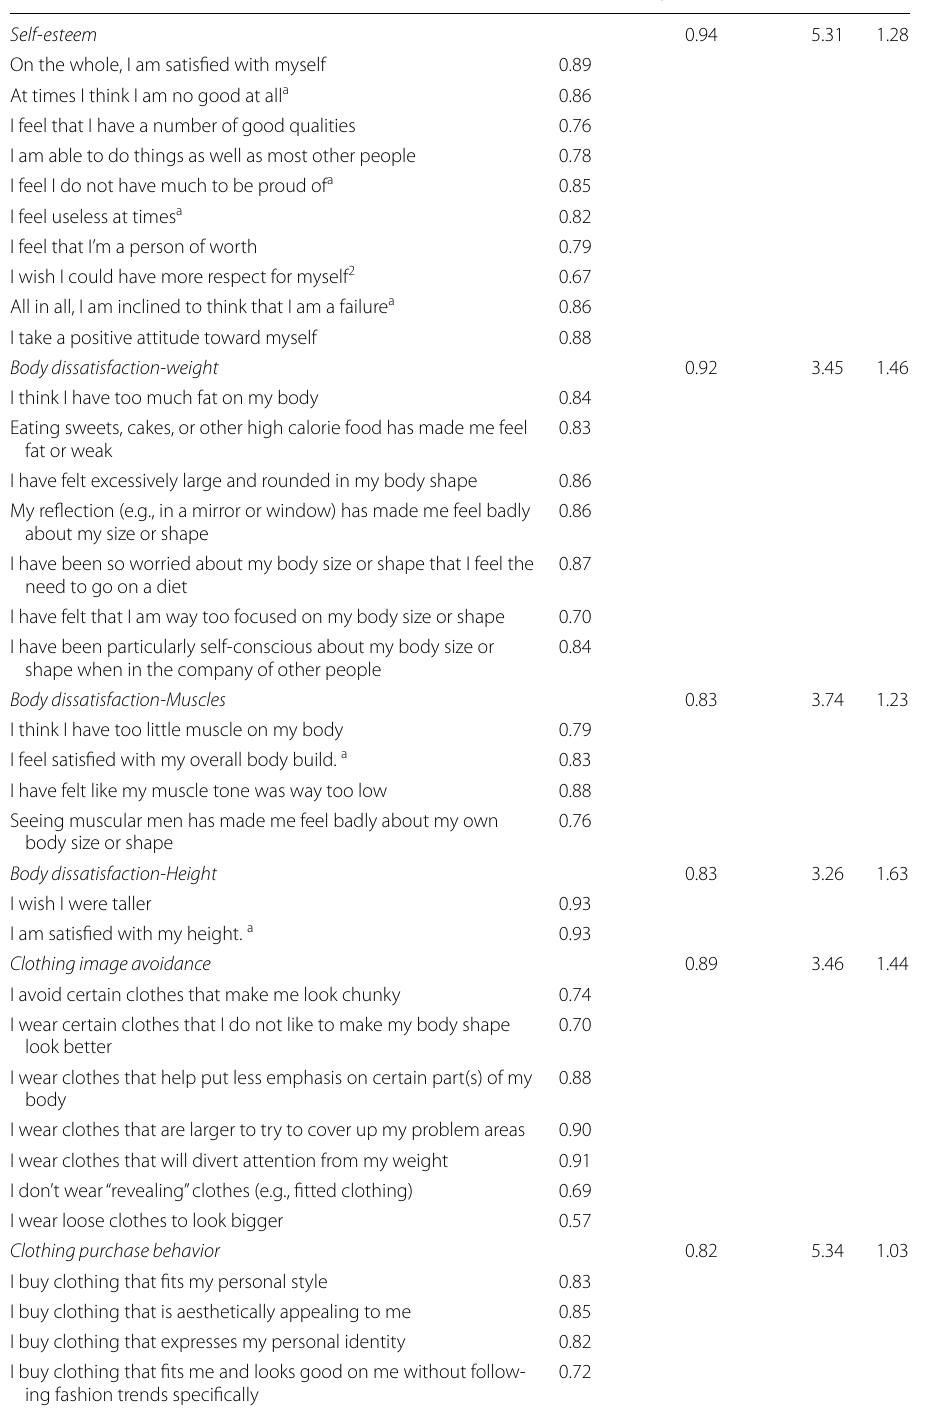
Table 1 Results of the exploratory factor analyses and related descriptive